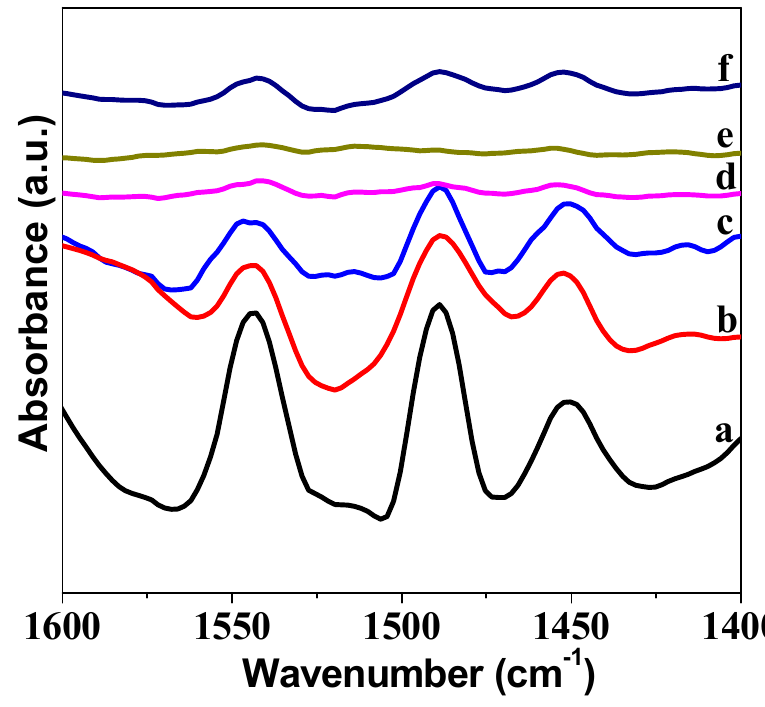
Figure 12. FTIR spectra in the pyridine region after desorption of the base at 100 °C: ( a ) HMCM-49, ( b ) 2Mo(N)-HMCM-49, ( c ) 4Mo(N)-HMCM-49, ( d ) 6Mo(N)-HMCM-49, ( e ) 8Mo(N)-HMCM-49, and ( f ) 6Mo(C)-HMCM-49.